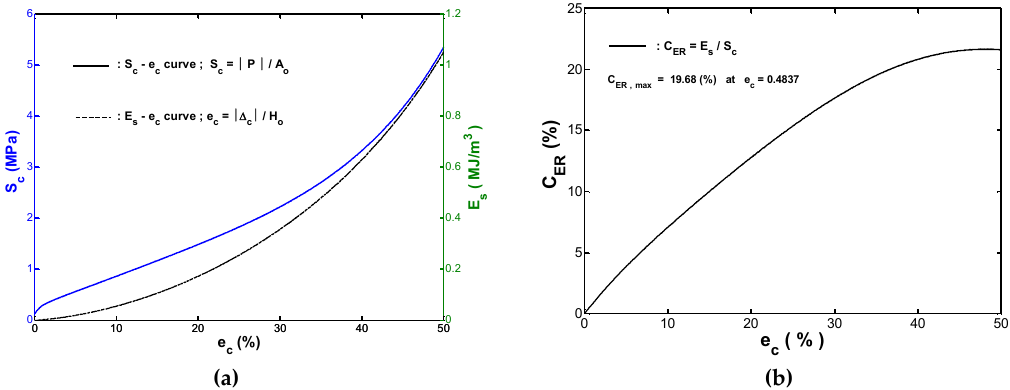
Figure 2. Experimental results of monotonic compression testing: ( a ) S c − e c and E s − e c curves, and ( b ) C ER − e c curve.